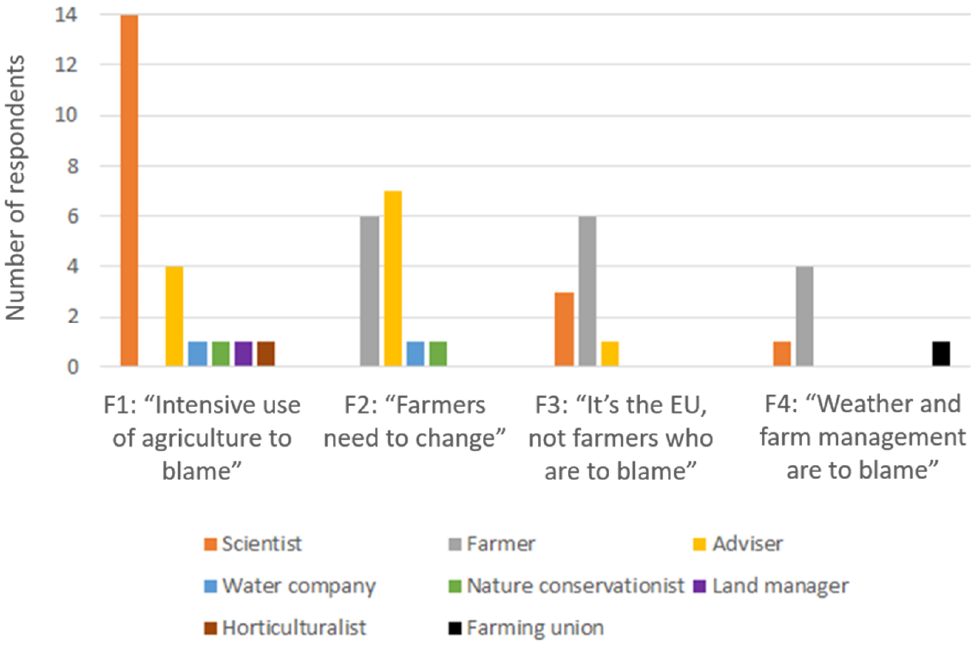
Figure 1. Professions of UK respondents loading onto the four problem factor groups.